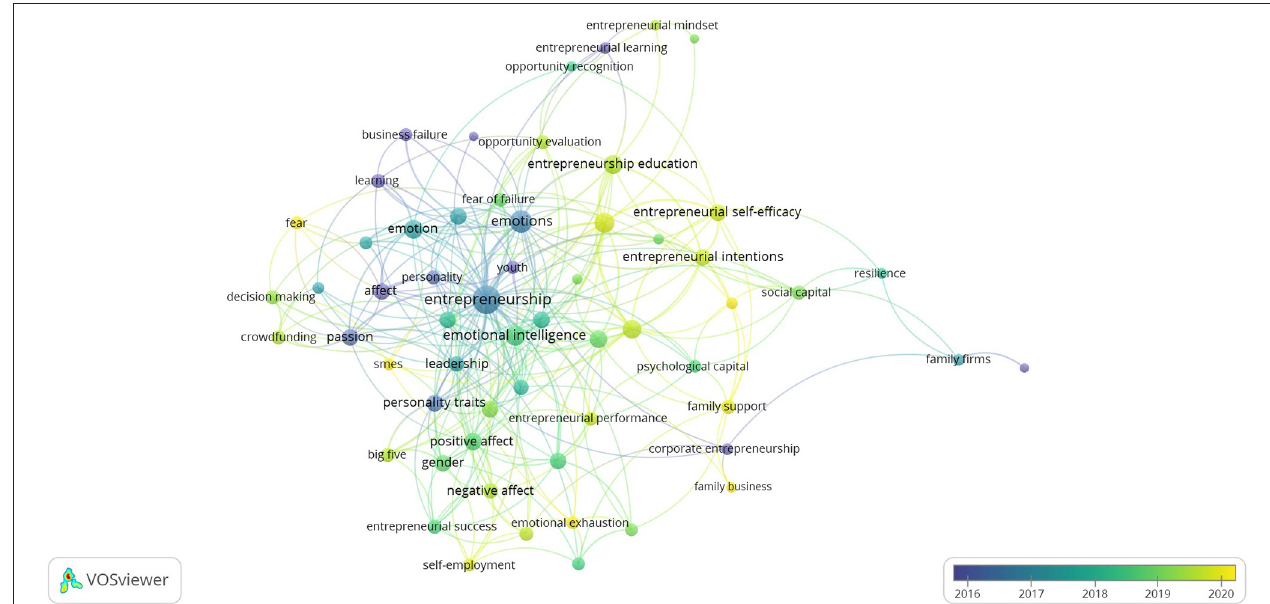
FIGURE 4 | Future